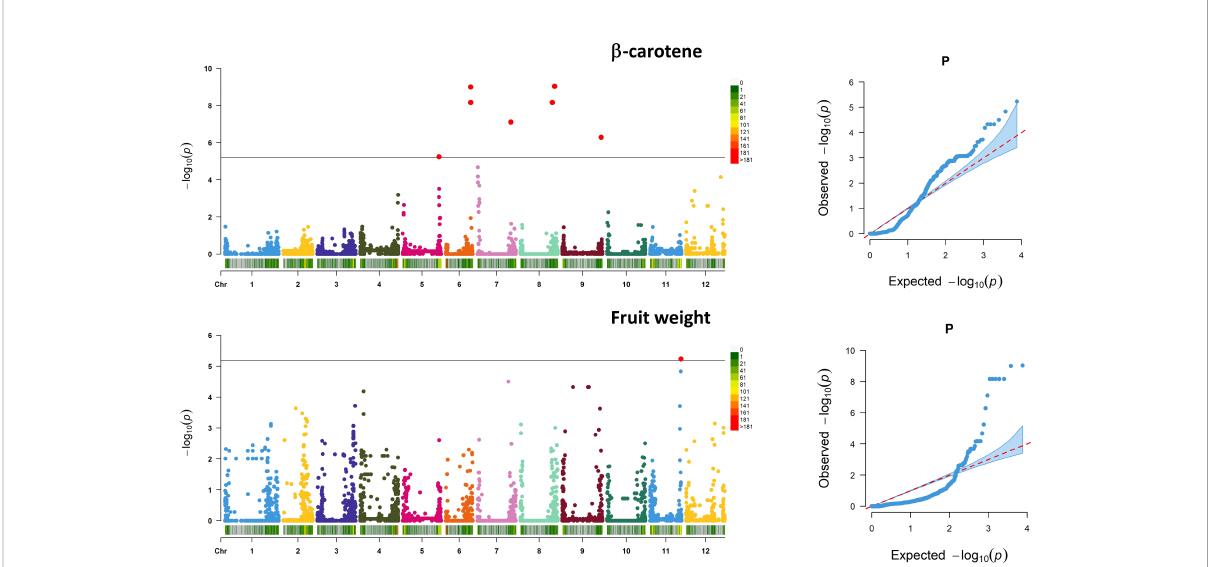
FIGURE 8 Marker – trait association analysis. Manhattan plots showing SNP associations for b -carotene (above) and fruit weight (below). Analysis has been performed considering 7,591 SNPs on 60 accessions evaluated across 2 years. The black horizontal line indicates a signi fi cant threshold ( − log 10 P -value) according to Bonferroni. The X -axis indicates the chromosome position and SNP density in 1 MB window following the legend on the right of each graph. For the associated traits, the QQ plot is reported on the